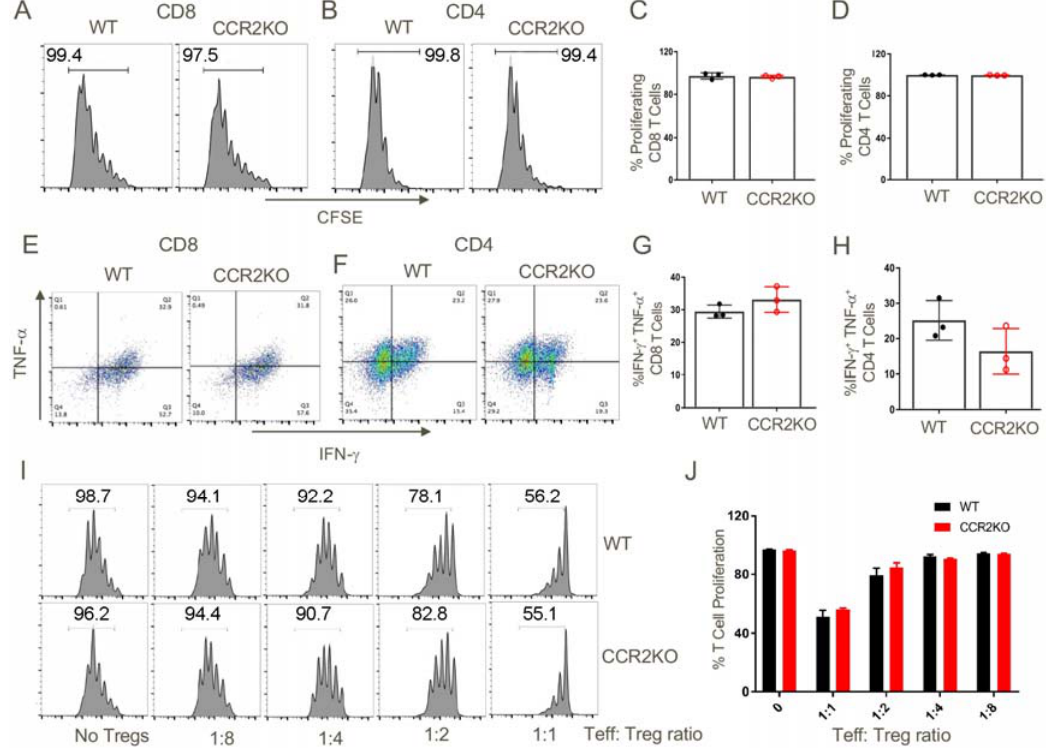
Figure 7. Genetic ablation of CCR2 did not affected the ability of T cells to proliferate and produce inflammatory cytokines or the suppressive capability of Foxp3+ Tregs. CFSE ‐ labelled T cells (70 × 10 6 ) from the spleens and lymph nodes of WT or CCR2KO C57BL/6 mice were injected i.v. into B6D2/F1 mice. After 3 days, spleens were harvested from the adoptively transferred B6D2/F1 mice and analyzed for the extent of proliferation of transferred T cells and their ability to produce inflammatory cytokines. ( A – D ) In vivo proliferation WT and CCR2KO CD8+ T cells and CD4+ T cells were comparable. ( E – H ) CD8 and CD4 T cells from WT and CCR2KO mice were equally capable of secreting inflammatory cytokines (TNF ‐α , IFN ‐γ ) upon restimulation in vitro. ( I , J ) WT and CCR2KO CD4+ Foxp3+ Tregs suppressed conventional CD4 T cell proliferation to a similar extent. Data are representative of three independent experiments.